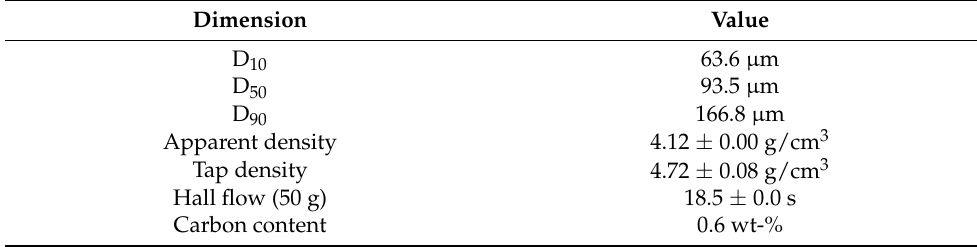
Table 1. Properties of the X65MoCrWV3-2